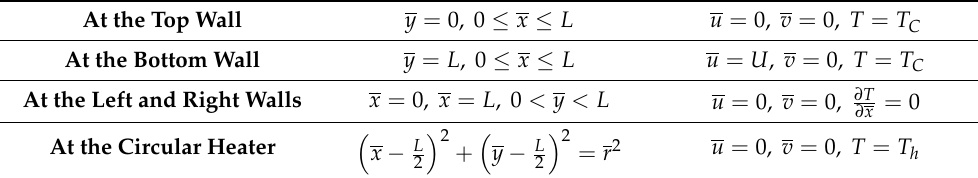
The boundary data is provided in Table 1. Table 1. The boundary data (See Figure 1 for detail). At the Top Wall At the Bottom Wall